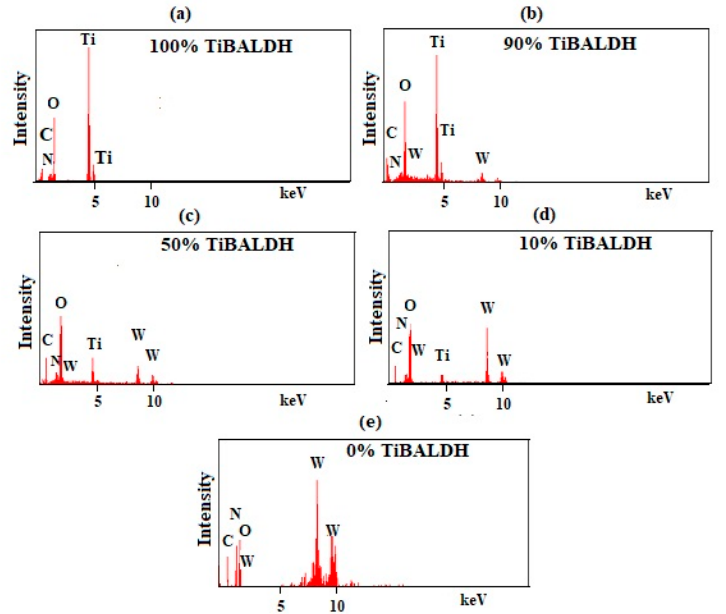
Figure 5. Energy-dispersive X-ray (EDX) spectra of the annealed fibers: ( a ) 100% TiBALDH, ( b ) 90% Figure 5. Energy ‐ dispersive X ‐ ray (EDX) spectra of the annealed fibers: ( a ) 100% TiBALDH, ( b ) 90% TiBALDH, ( c ) 50% TiBALDH, ( d ) 10% TiBALDH, and ( e ) 0% TiBALDH. TiBALDH, ( c ) 50% TiBALDH, ( d ) 10% TiBALDH, and ( e ) 0% TiBALDH. Fourier-transform infrared spectra obtained before and after annealing the fibers are presented in Figure 6. The as-spun fibers have peaks between 3500 and 3200 cm − 1 that can result from O-H stretching bonds from water and N-H stretching bonds from AMT [35]. The peak observed at about 2900 cm − 1 is due to C-H vibrations from TiBALDH and PVP. Vibrations by C=O bonds were observed at about 1700 cm − 1 [36]. -CH bending bonds of CH 2 were observed around 1470 cm − 1 , while C-O stretching bonds of PVP were observed between 1250 and 1200 cm − 1 . The spectra of the annealed fibers showed the presence of some functional groups. This confirmed that annealing in an inert environment did not fully decompose the polymer. The peak around 2300 cm − 1 can be caused by C-N stretching movements [37]. Peaks due to stretching vibrations of O-W bonds were observed at about 600 cm − 1 .